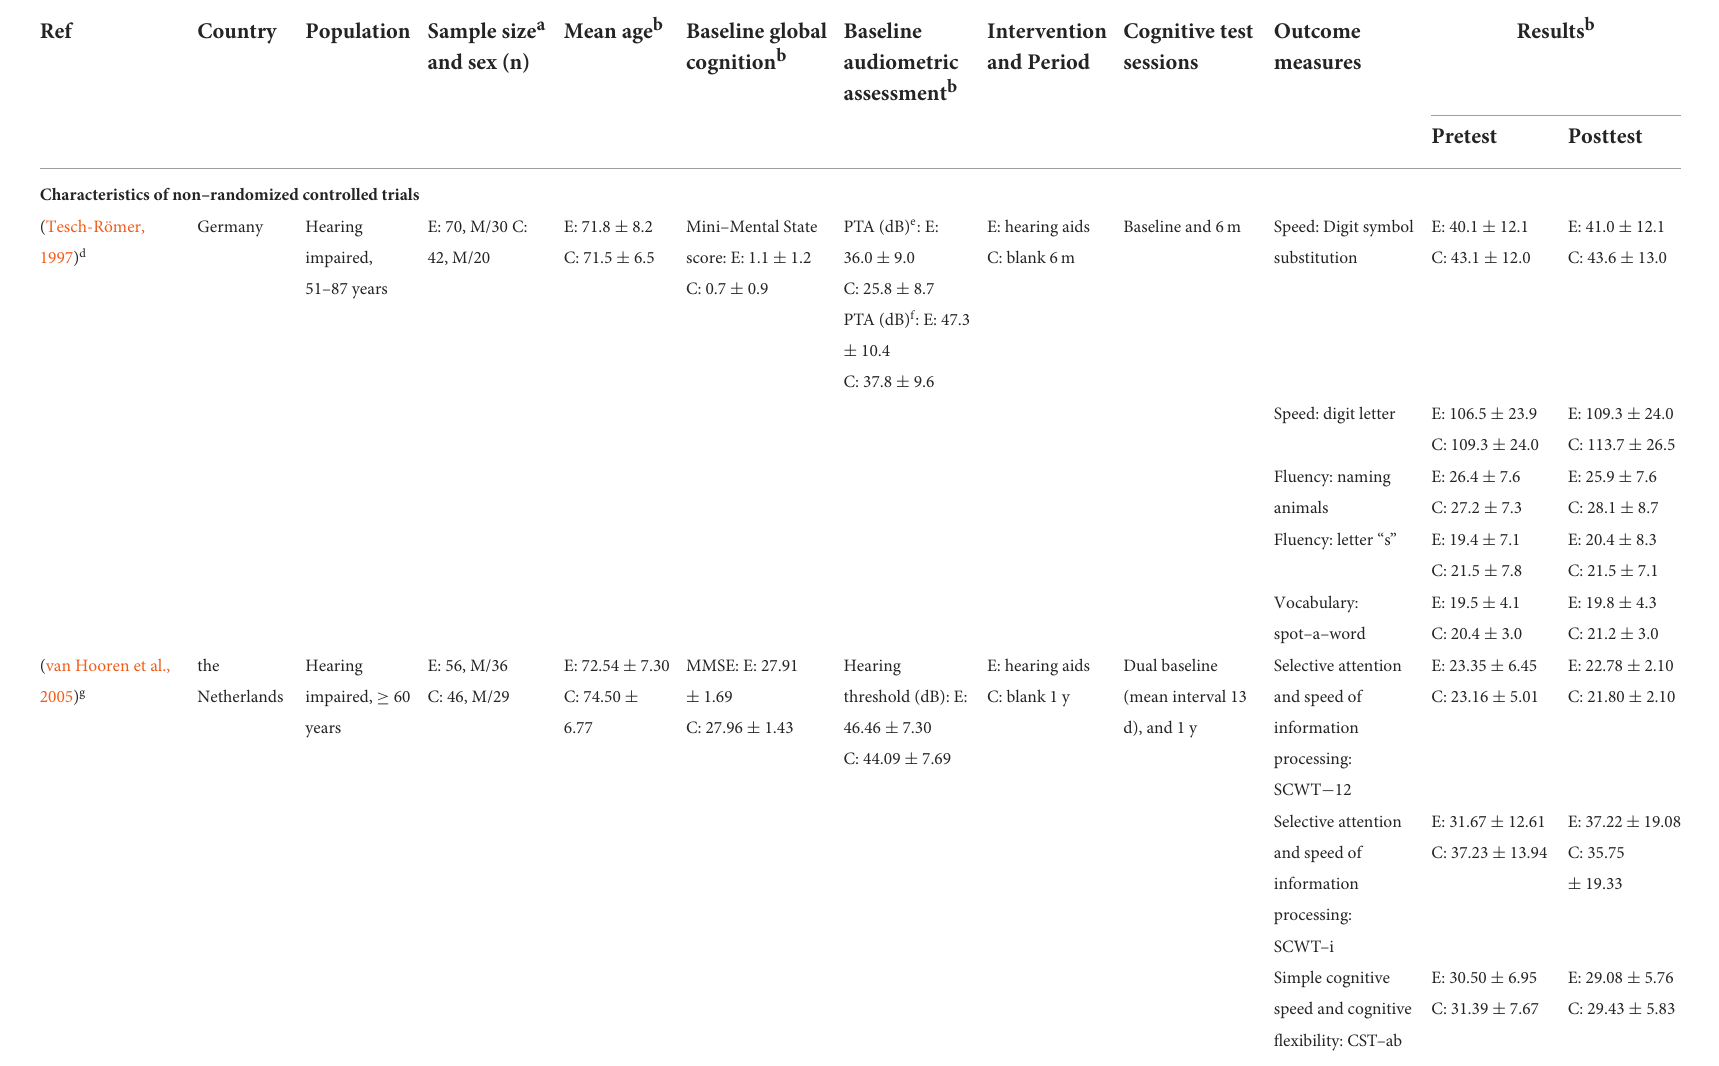
TABLE 2 Characteristics of NRSIs. Ref